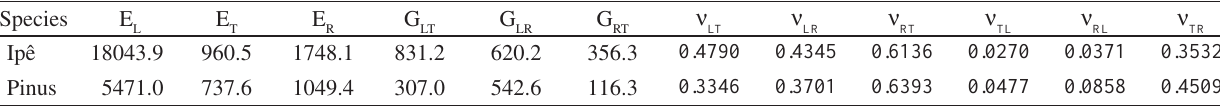
and G in MPa ). i ij